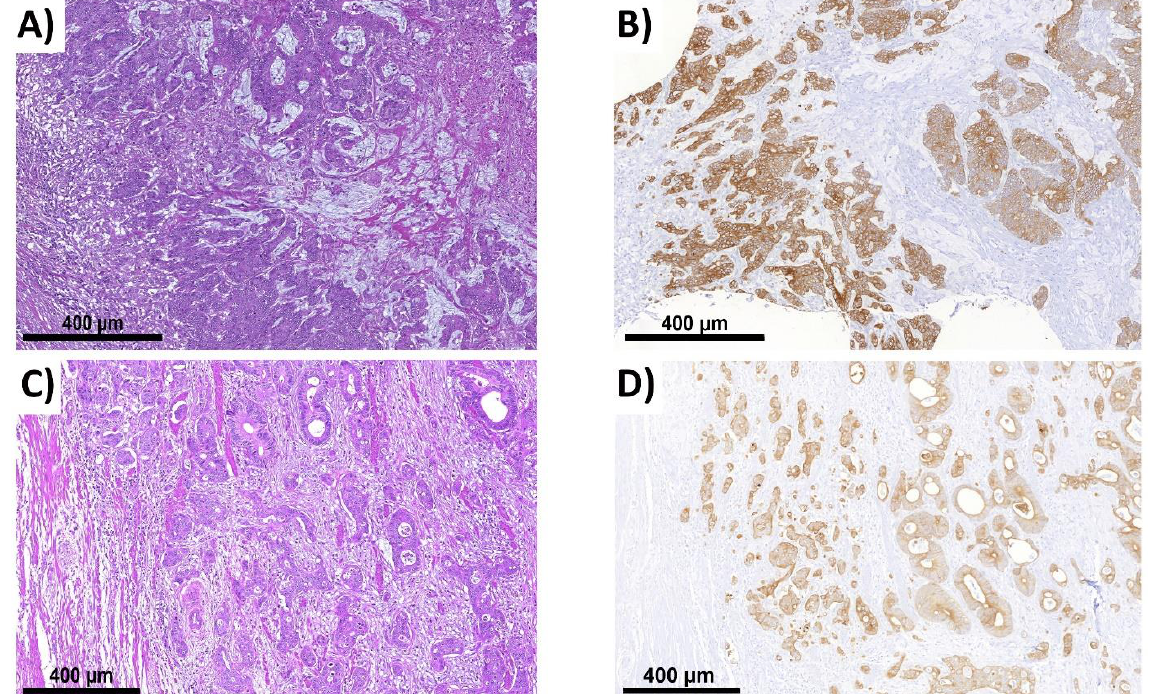
Figure 7. Comparison between HE and pancytokeratin ( A – D ). For technical data, see legend of Figure 1. All pictures are taken with 9 × magnification. ( A , C ) A part of a section in HE; ( B , D ) corresponding areas to ( A , C ) in pancytokeratin. Even at this magnification, a few bud candidates can be estimated by visual inspection based on